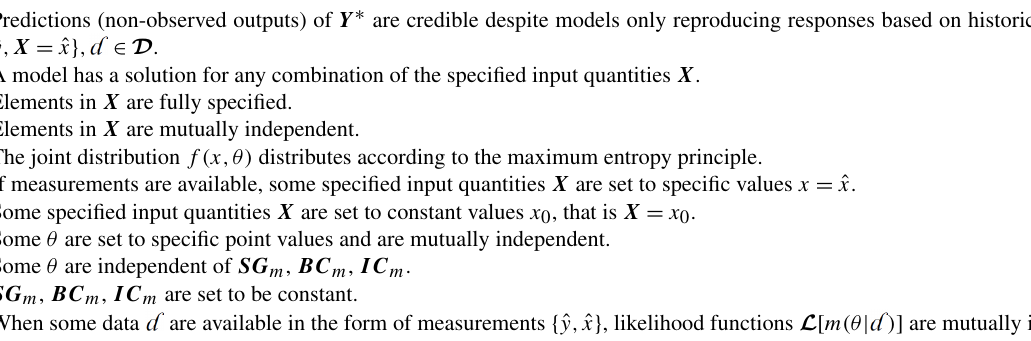
Table 1. Some enforced assumptions in UQ for geohazard assessments. Predictions (non-observed outputs) of Y ∗ are credible despite models only reproducing responses based on historical data = { ˆ Y = ˆ y, X = ˆ x } , ∈ D . A model has a solution for any combination of the specified input quantities X .